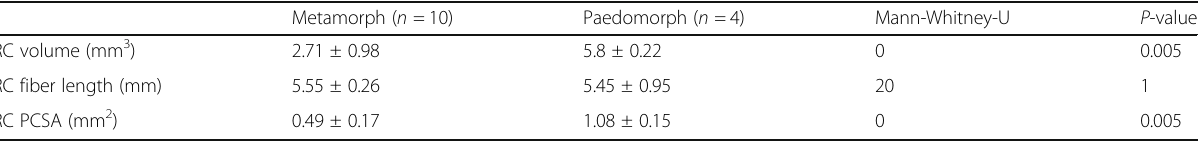
Table 2 Volume, fiber length and PCSA of the rectus cervicis muscle in paedomorphic and metamophic I. alpestris . Values are mean ± 1 standard deviation. The Mann-Whitney-U tests compare values between the two morphs. Significance level was adjusted to p ≤ 0.017 after simultaneous Bonferroni